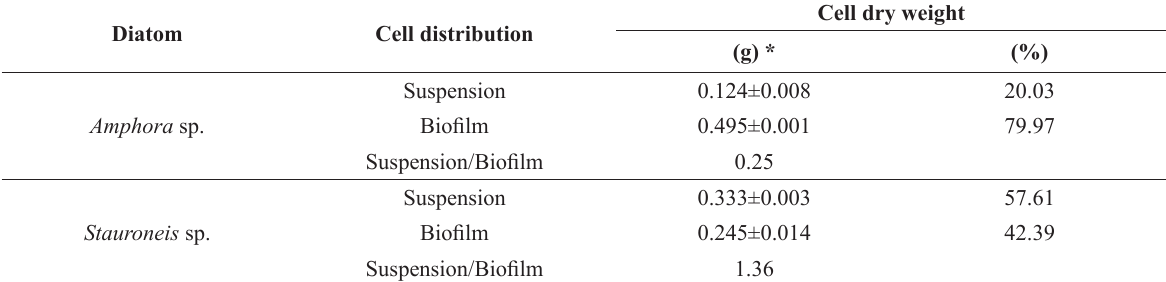
The cell distributions in suspensions and biofilms of the diatoms Amphora sp. and Stauroneis sp.